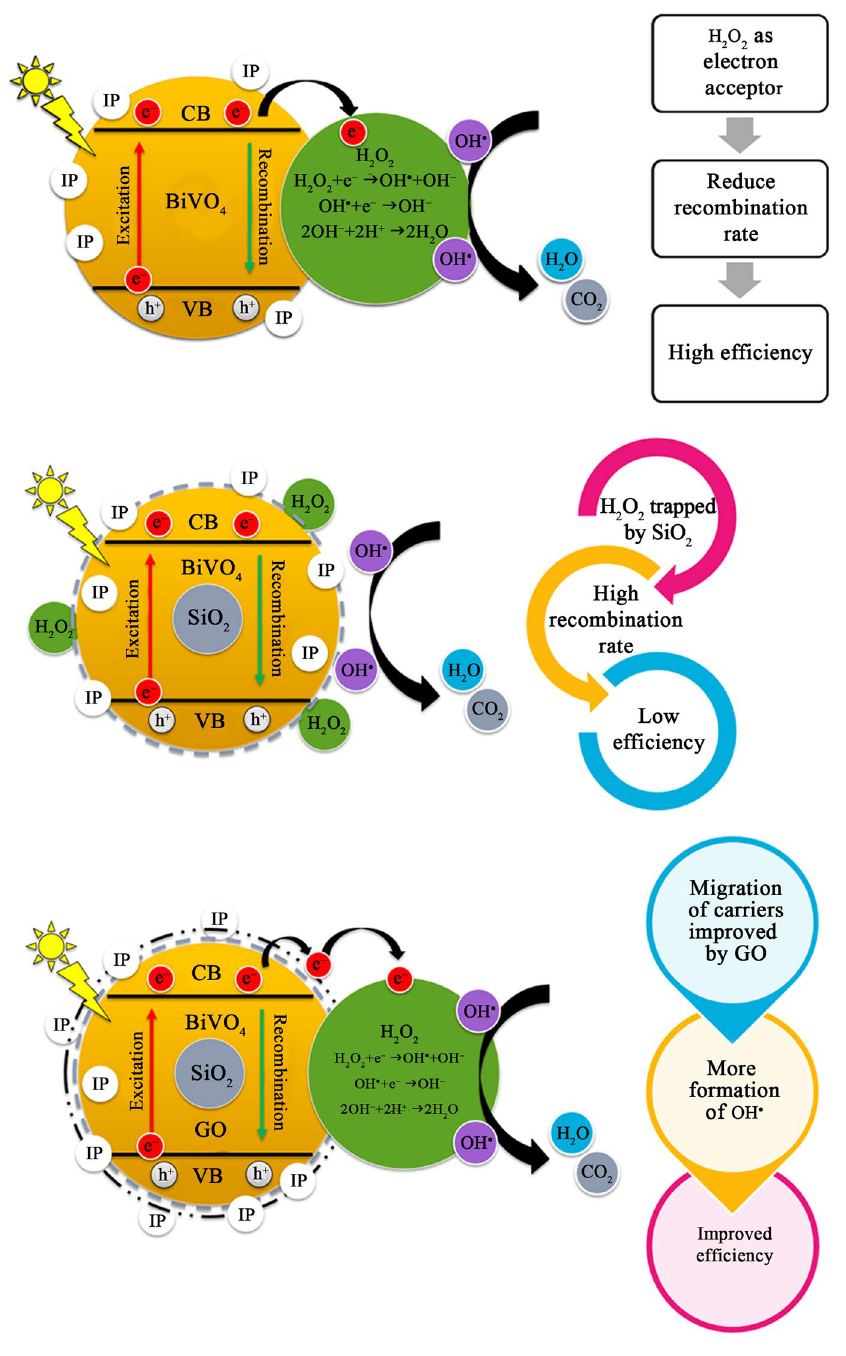
Figure 7. Photodegradation of phenol over BiVO 4 , BiVO 4 /SiO 2 , BiVO 4 /SiO 2 /GO with the presence of H 2 O 2